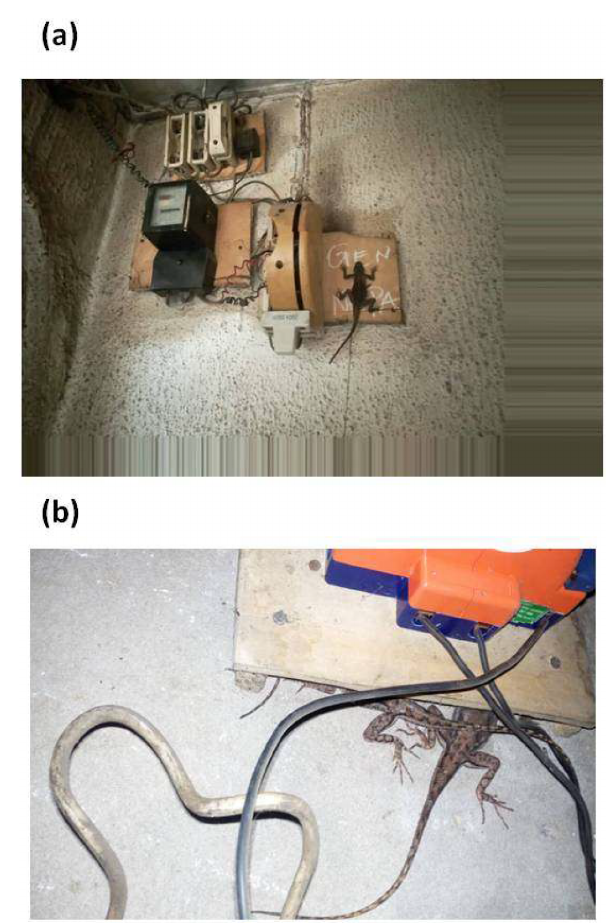
Figure 1. Example of Agama agama resting on (a) or below (b) warm electric panels for overnight retreats.